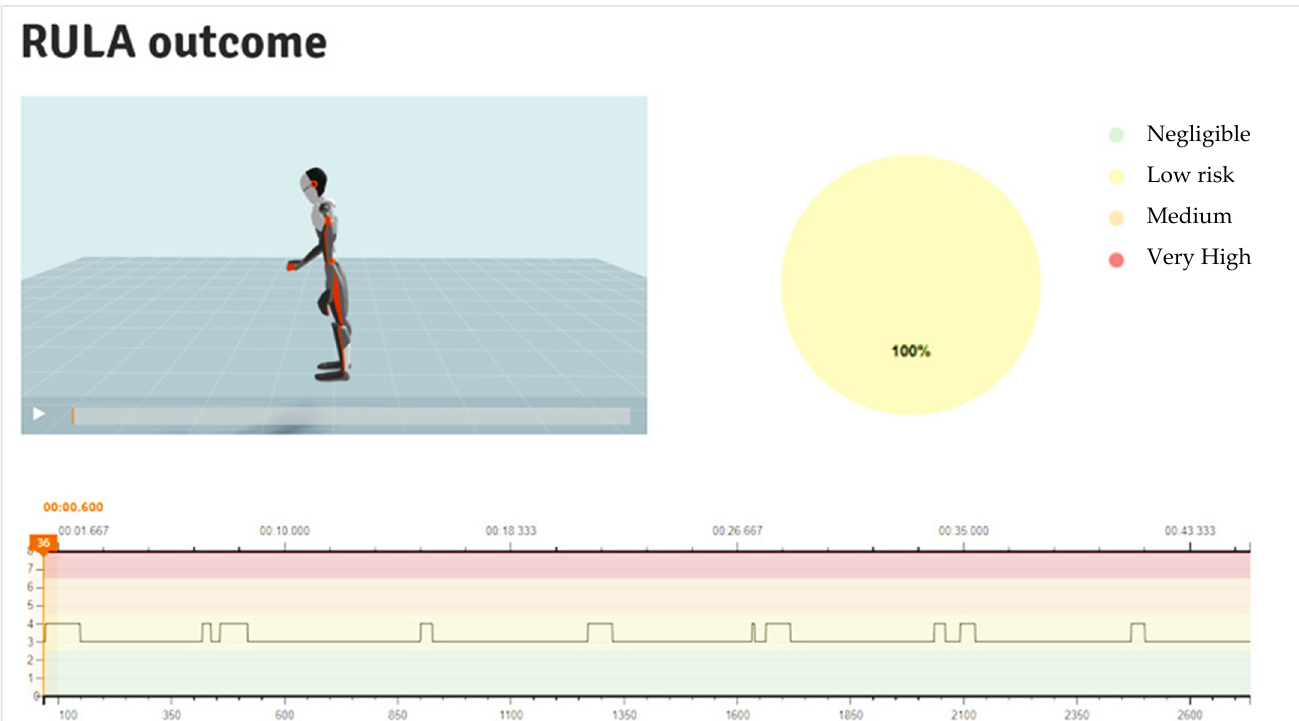
Figure 11. Example of the assessment reported by the XSens-RULA algorithm. Table 5 . Summary of the XSens-RULA assessment for both workers across the conditions tested.